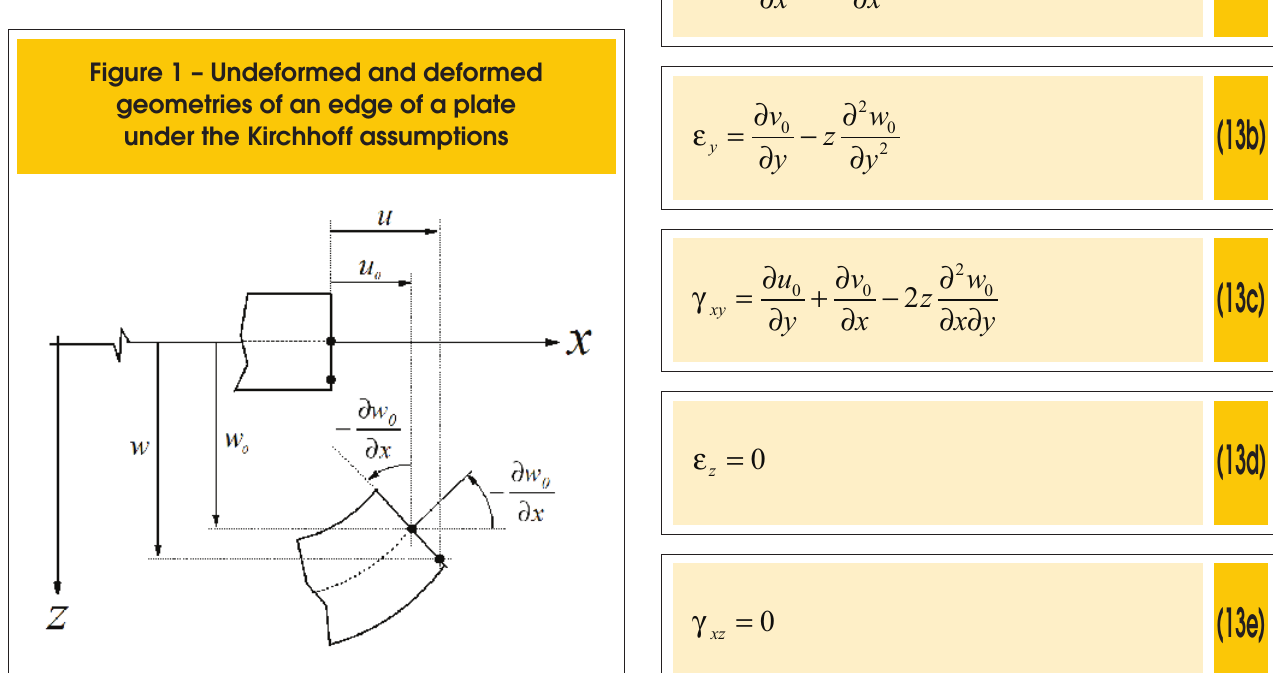
Figure 1 – Undeformed and deformed geometries of an edge of a plate under the Kirchhoff